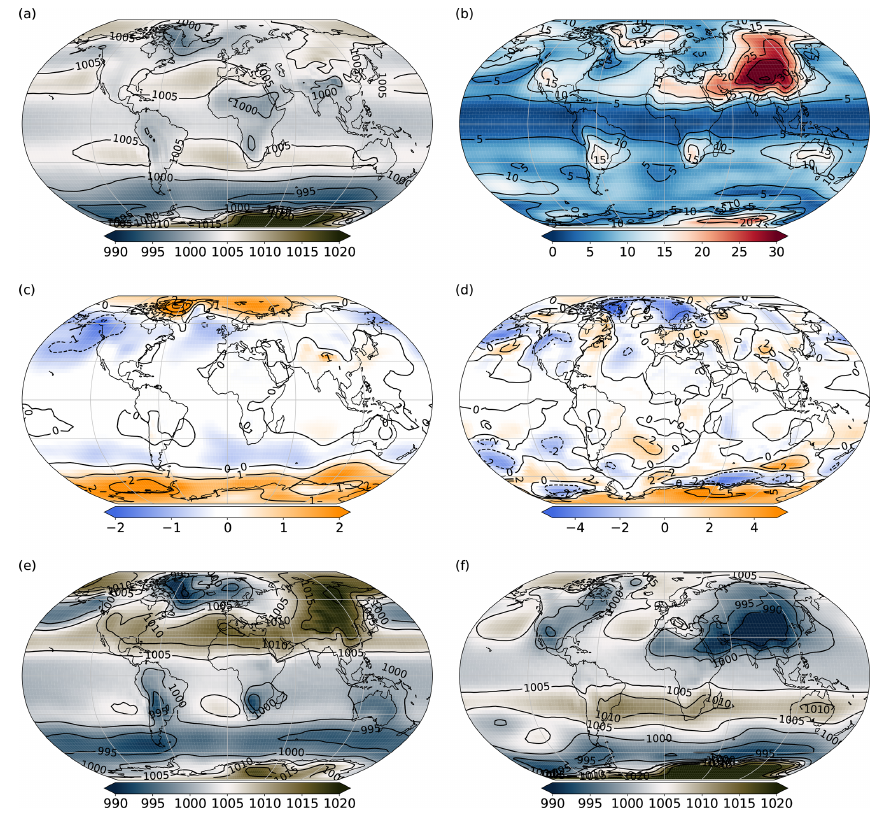
Figure 6. Time mean (years 2001–2025) plots showing sea level pressure (mbar): (a) annual mean, (b) seasonal range, (c) difference in sea level pressure for L20–L35 and (d) difference in seasonal range (L20–L35), plus values for the months of (e) January and (f) July from the L35 simulation.